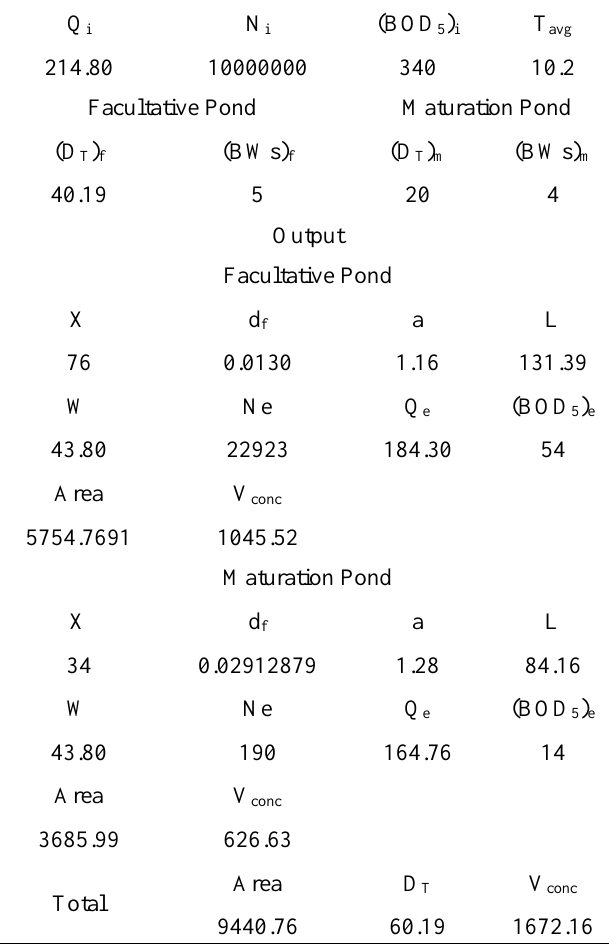
Results with the Optimization